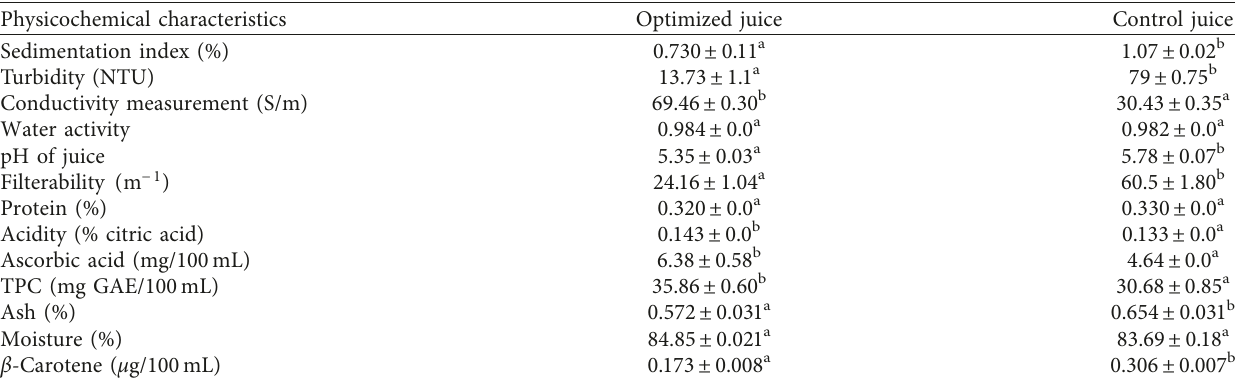
Table 8: Physicochemical properties of sapodilla juice (mg/100 mL or